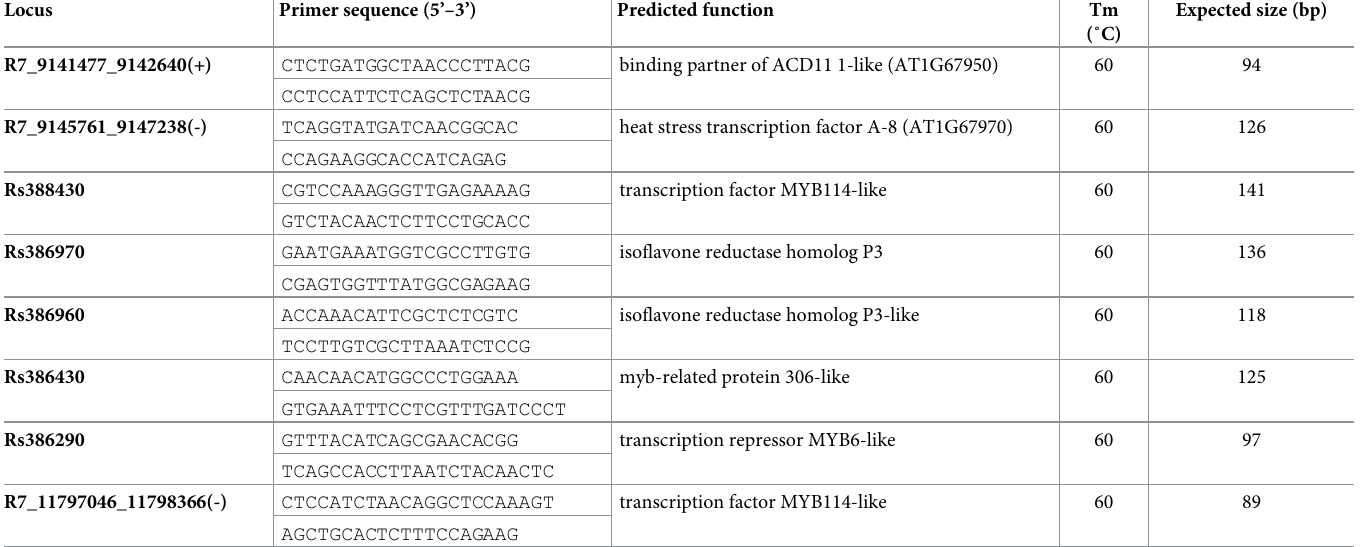
Table 2. PCR primers used for